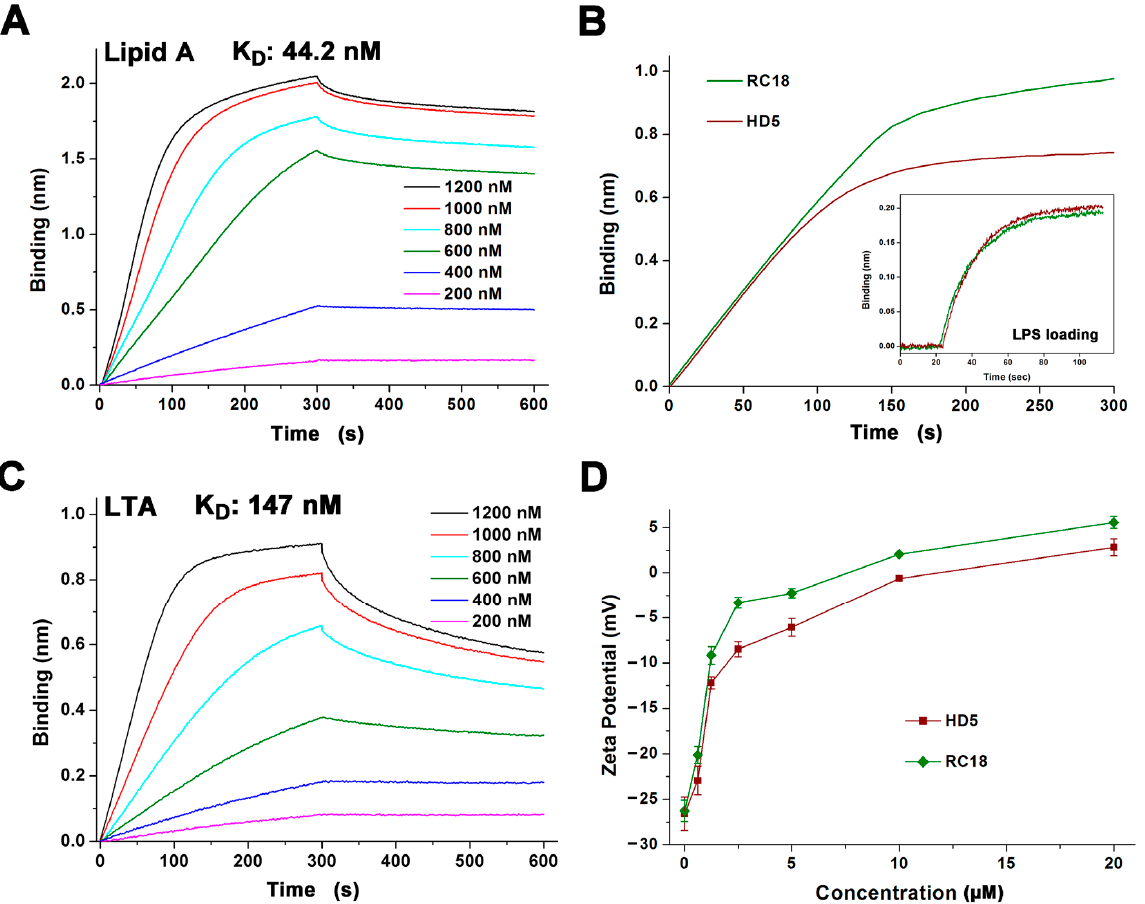
Figure 2. ( A ) Binding kinetics of RC18 to lipid A. Peptides were prepared in 10 mM sodium phosphate buffer (pH 7.4) at concentrations of 200, 400, 600, 800, 1000 and 1200 nM. ( B ) Thickness of the bond between 1000 nM HD5 and RC18 to immobilized LPS on AR2G biosensors. The results showed that more RC18 peptides were recruited to LPS than that of HD5 peptides. ( C ) Binding kinetics of RC18 to LTA. ( D ) Surface charge of microbes exposed to HD5 and RC18 at concentrations of 0.625, 1.25, 2.5, 5, 10, and 20 µ M. The results are shown as the mean ±